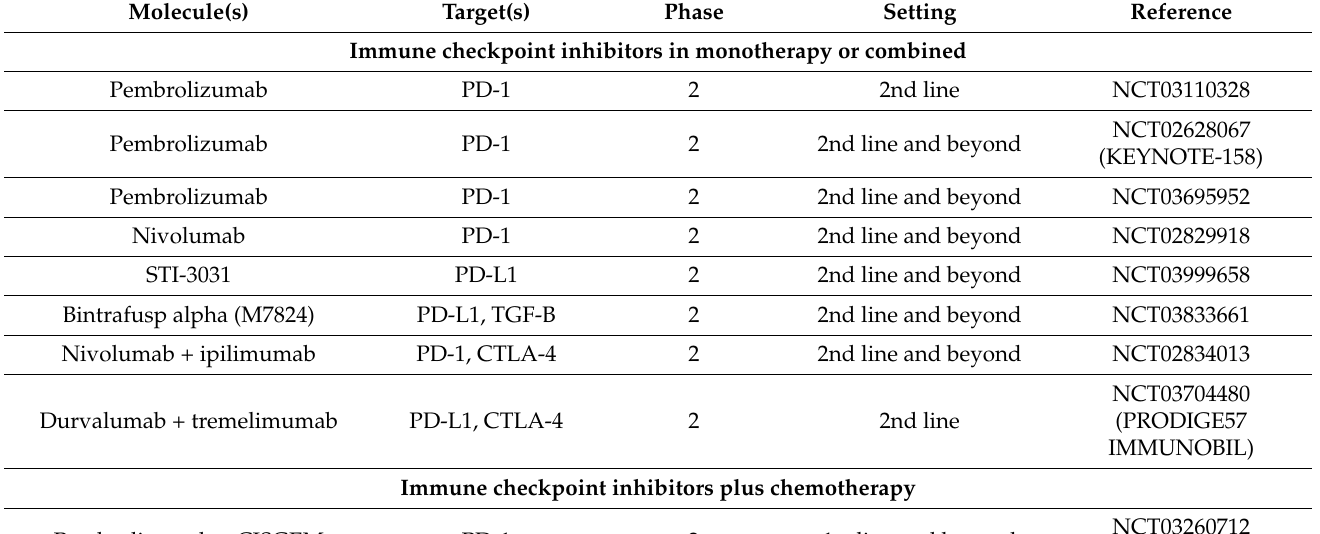
Table 2. Main ongoing phase 2 or 3 trials of immunotherapies in biliary tract